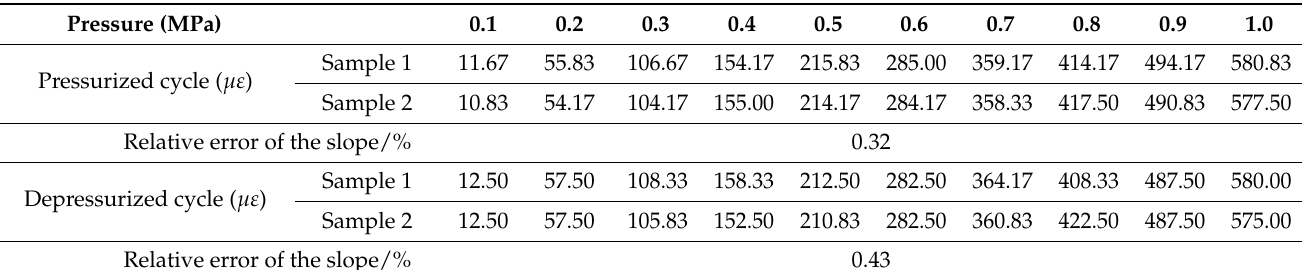
Table 4. Experimental data and relative